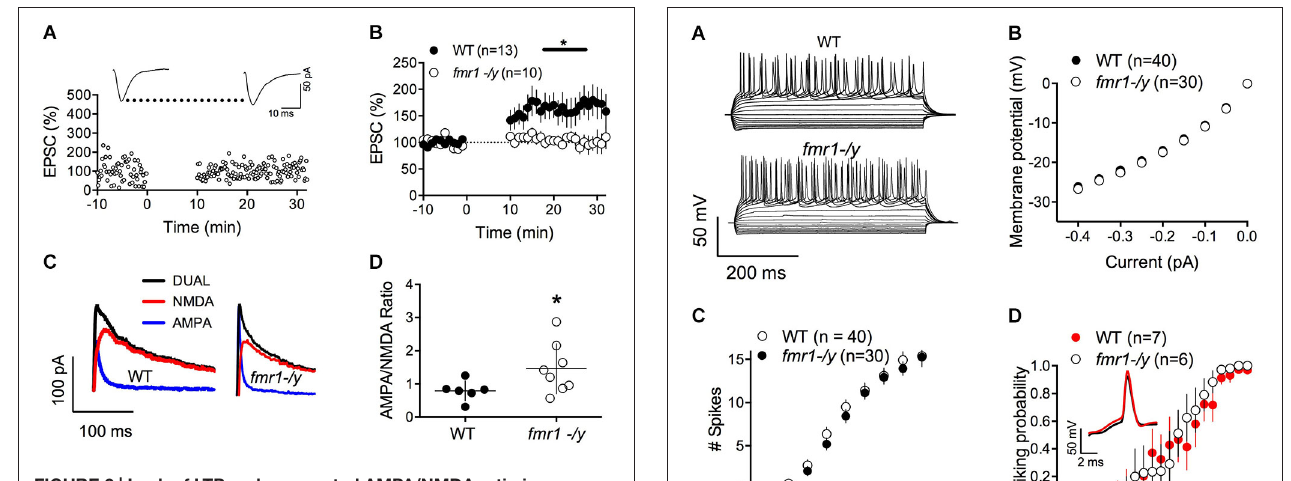
FIGURE 2 | Lack of LTP and augmented AMPA/NMDA ratio in accumbens MSN of fmr1-/y mice. (A) Representative experiment illustrating the lack of LTP in fmr1-/y mice. Inset shows EPSCs averaged over 10 min baseline and 20 min after the induction protocol respectively. (B) Averaged time-courses of LTP experiments for both genotypes. LTP was absent in fmr1-/y mice ( p = 0.0415 Mann-Whitney test) (C) Representative current traces of a wild type (left) and fmr1-/y (right) MSN voltage clamped at − 40 mV to illustrate the computation of A/N ratios. Black: Dual AMPA and NMDA response. Blue: isolated AMPA response after application of d-APV (50 µ M). Red: NMDA response extracted via subtraction of AMPA response from the dual response. (D) A/N ratios were larger in fmr1-/y mice ( p = 0.043, Mann-Whitney test).